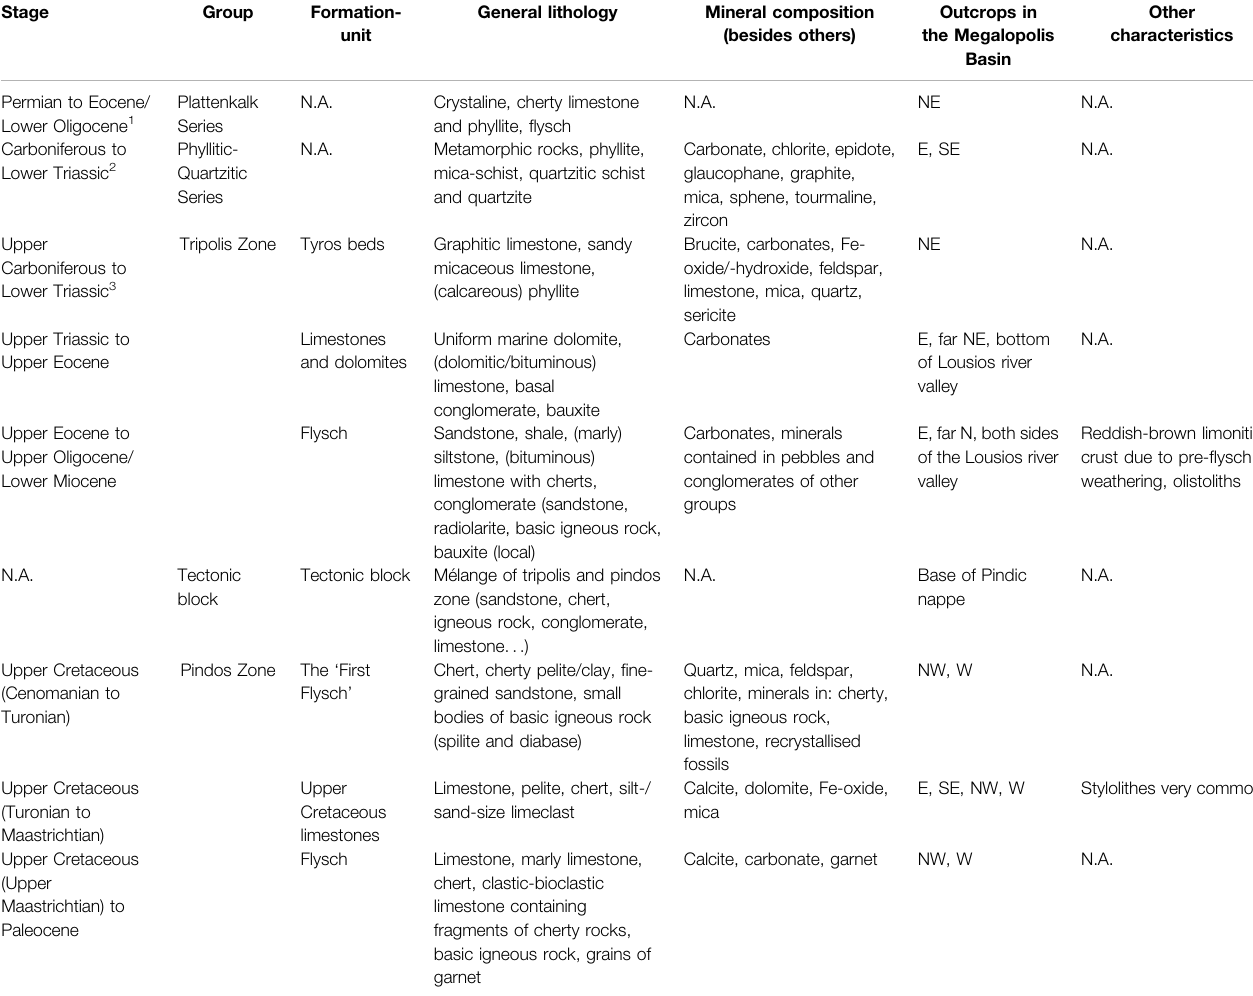
TABLE 1 | Geology of the Megalopolis Basin according to Tsiftsis (1987), 1 Dornsiepen et al. (2001), 2 Baltatzis and Katagas (1984), 3 Lekkas et al.